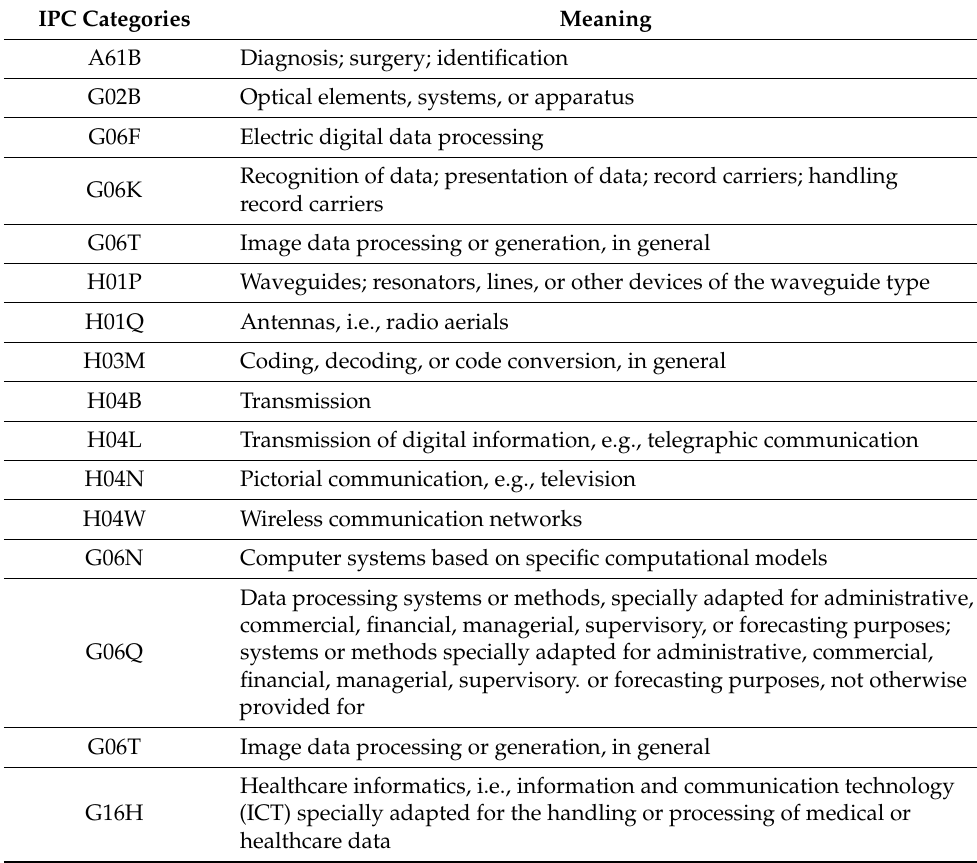
Table A1. Definition of IPC